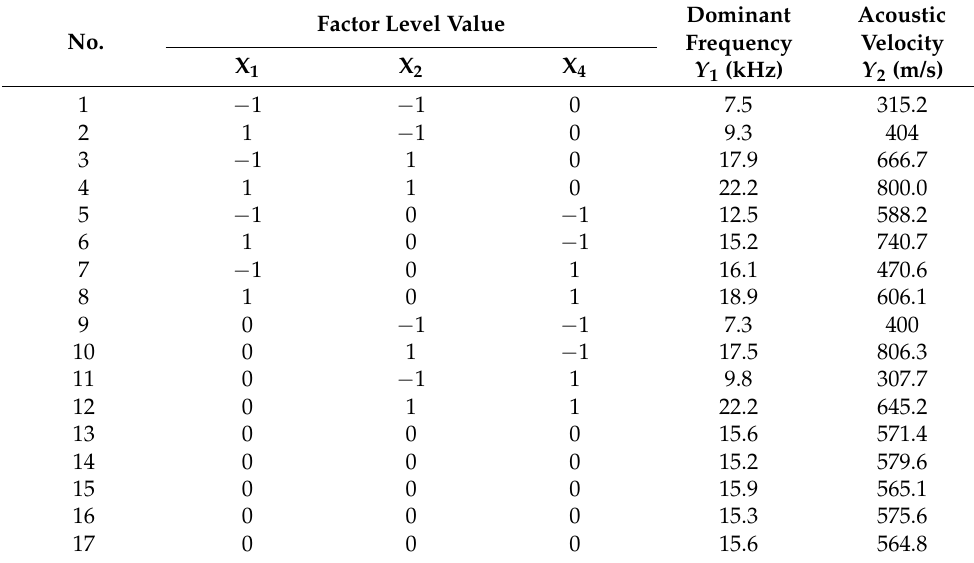
Table 8. The design scheme and results of